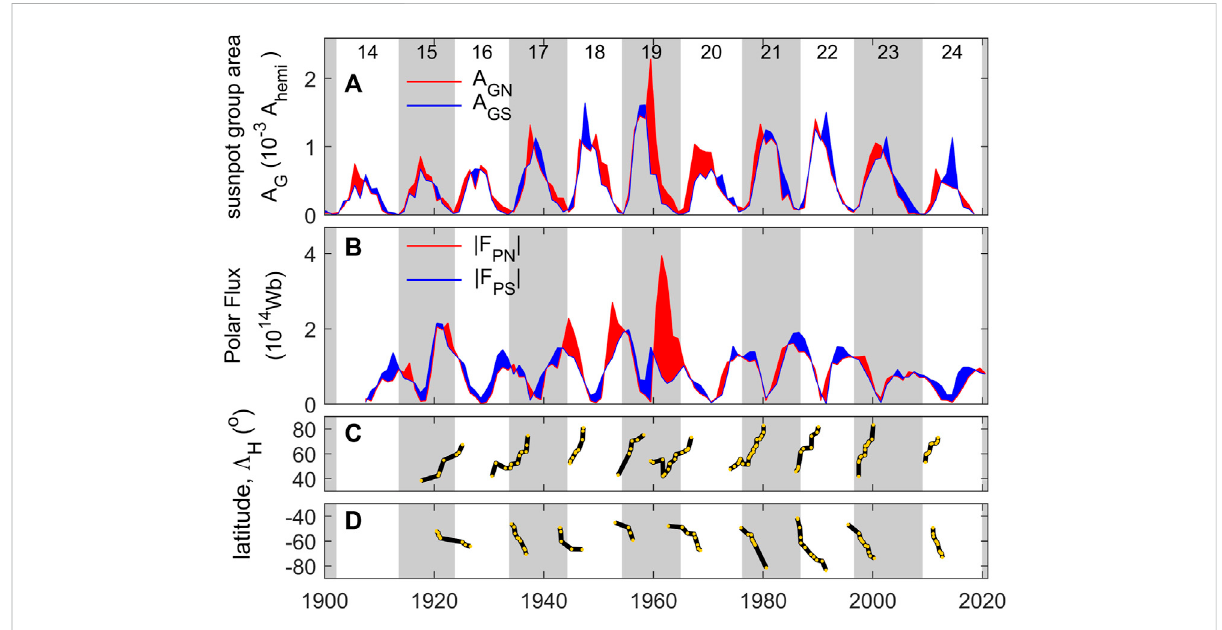
FIGURE 5 (A) Hemisphericsunspot group areas compiled and intercalibrated byMandal etal. (2020). Red is for thenorther hemisphere area A GN and blue forthesouthern, A GS andshadedareasshowthedifferencebetweenthetwo,colouredaccordingtothelargerofthetwo. (B) Thepolar fl uxesderived from polar faculae, F PN and F PS , as discussed in the previous section, and shown using the same format as (A) . (C) Observations of the polewardmost PCFfoundbyXuetal.(2021)inthenorthernhemisphere:observedheliographiclatitudesareshownbyyellowpoints,whichareconnectedbya black line. (D) Same as part (C) for the southern